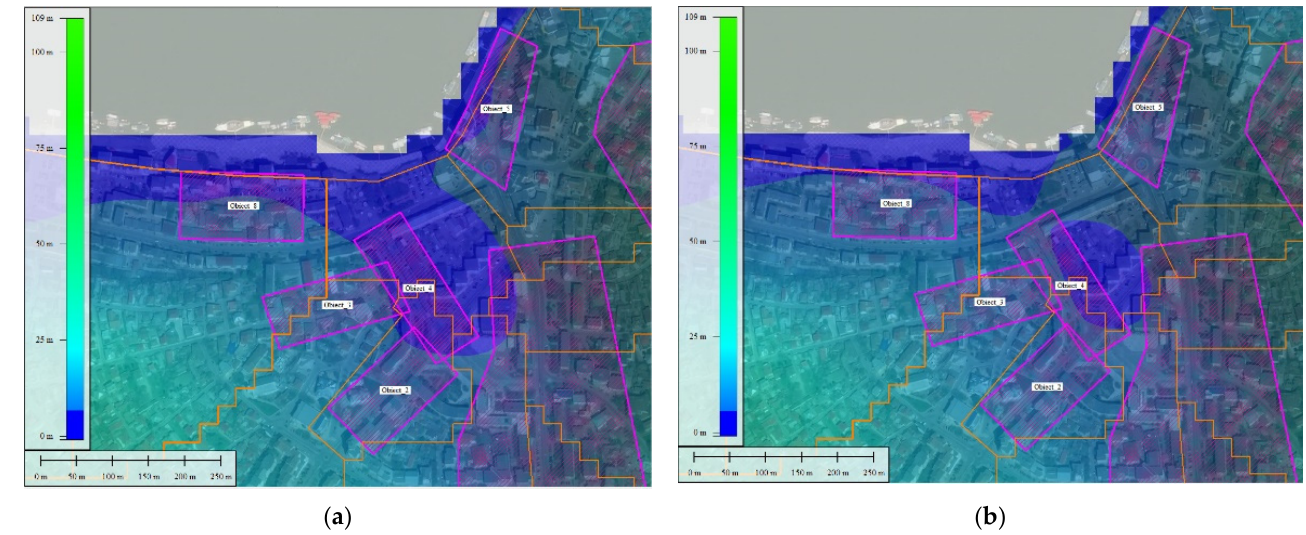
Figure 20. The flooded areas derived for the 2016 event: ( a ) Hypothesis 1 and ( b ) Hypothesis 2.